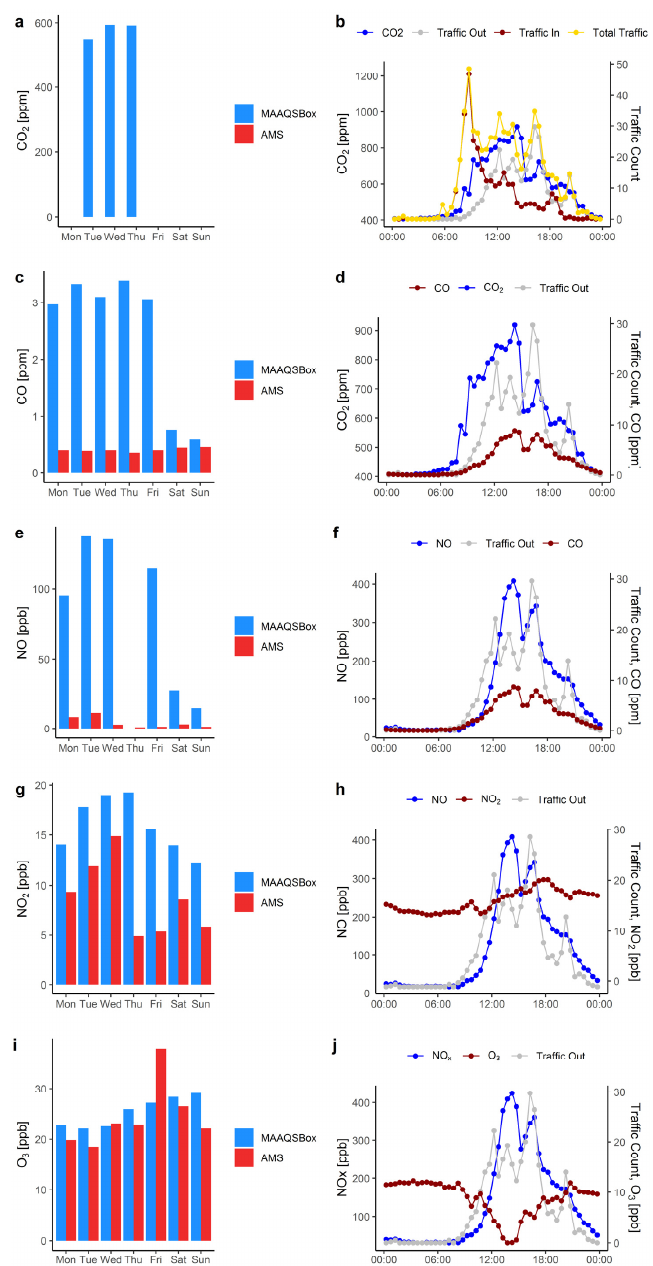
Figure 3. ( a ) Daily CO 2 Concentrations. ( b ) daily variation of entry, exit, and total traffic, and CO 2 concentration with time of day, weekday 30 min averages. ( c ) Daily average CO concentrations measured in the garage by the MAAQSBox and ambient levels measured at the nearest AMS and ( d ) daily variation of CO and CO 2 concentration and exit traffic, weekday 30 min averages. ( e ) Daily average NO concentrations measured in the garage by the MAAQSBox and ambient levels measured at the nearest AMS and ( f ) daily variation of NO and CO concentration and exit traffic, weekday 30 min averages. ( g ) Daily average NO 2 concentrations measured in the garage by the MAAQSBox and ambient levels measured at the nearest AMS and ( h ) daily variation of NO 2 and NO concentration and exit traffic, weekday 30 min averages. ( i ) Daily average O 3 concentrations measured in the garage by the MAAQSBox and ambient levels measured at the nearest AMS and ( j ) daily variation of O 3 and NOx concentration and exit traffic, weekday 30 min